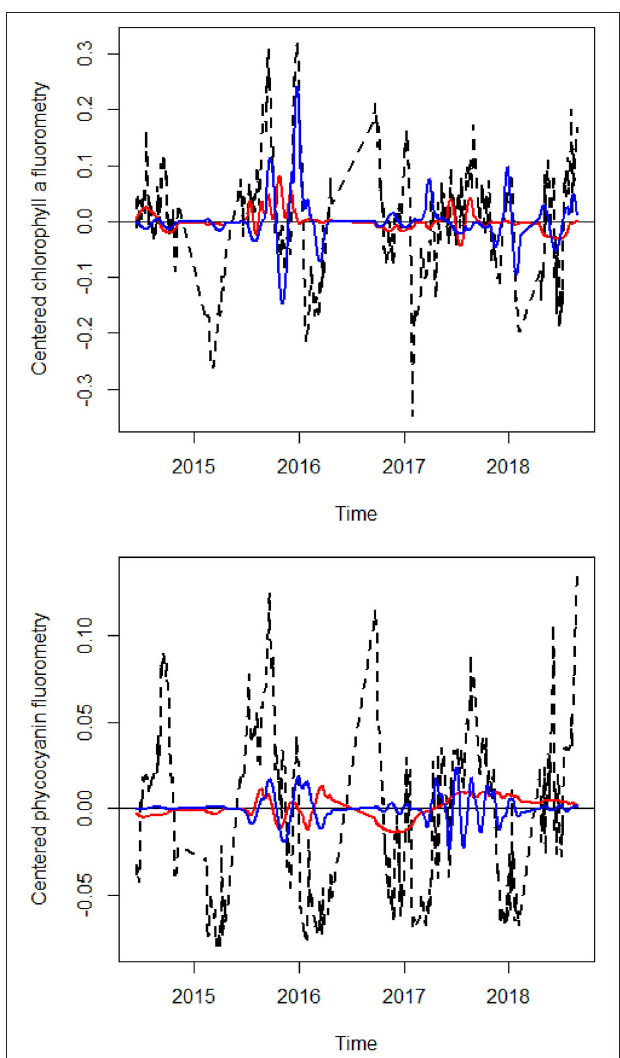
FIGURE 4 | Line plots of daily chlorophyll a and phycocyanin flurorometry, along with their fitted values according to the sets of dbMEM variables related to water discharge. Observed values are in black, fitted values relating to dbMEM variables positively related to water discharge are in red and negatively related are in blue.